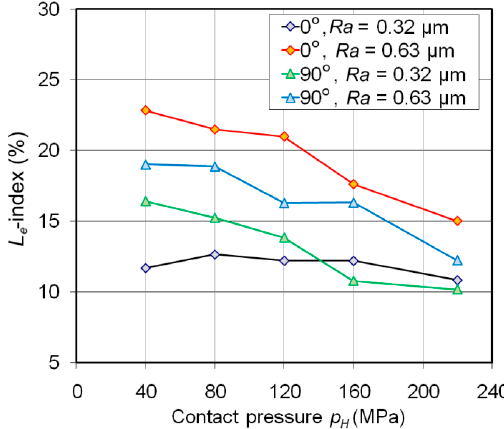
Figure 11. Effect of contact pressure on the value of the L e -index. Figure 11. E ff ect of contact pressure on the value of the L e